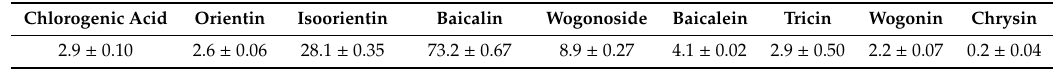
Figure 4. Identification and quantitative analysis of components from BS21: ( A ) cholorogenic acid, ( B ) orientin, ( C ) isoorientin, ( D ) baicalin, ( E ) wogonoside, ( F ) baicalein, ( G ) tricin, ( H ) wogonin, and ( I ) chrysin. Identification was based on comparisons of retention times and UV spectra with those of commercial standards. The components were quantified based on the peak area at 270 nm. Table 1. BS21 extract constituents.